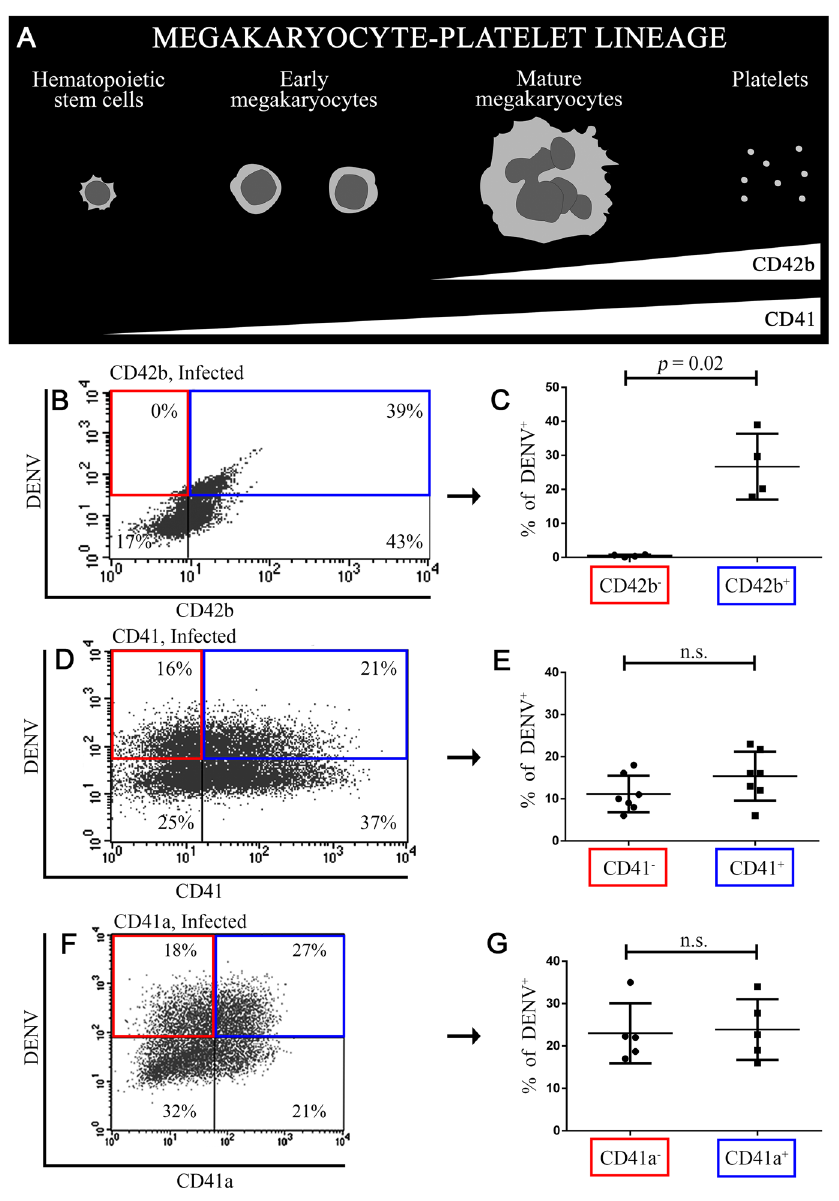
Figure 1. Tropism of CD42b, CD41 and CD41a in dengue virus. ( A ) CD42b is the marker of mature megakaryocytes and platelets 25 . CD41 is the marker of early megakaryocytes 15 . ( B – G ) MEG-01 cells were infected with DENV (MOI = 0.5) for 2 hours and washed with PBS. The cultures were maintained in fresh medium for another 7 days before being double immunostained. (B,D,F) Representative two-dimensional plot of surface platelet receptors and intracellular DENV ( (B) CD42b, (D) CD41, (F) CD41a). (C,E,G) Percentage of DENV + cells without and with expressing platelet receptors ( (C) CD42b (n = 4), (E) CD41 (n = 7), (G) CD41a (n = 5)). Error bars represent mean ± SD. Statistical significance was determined by using the two-tailed Mann– Whitney